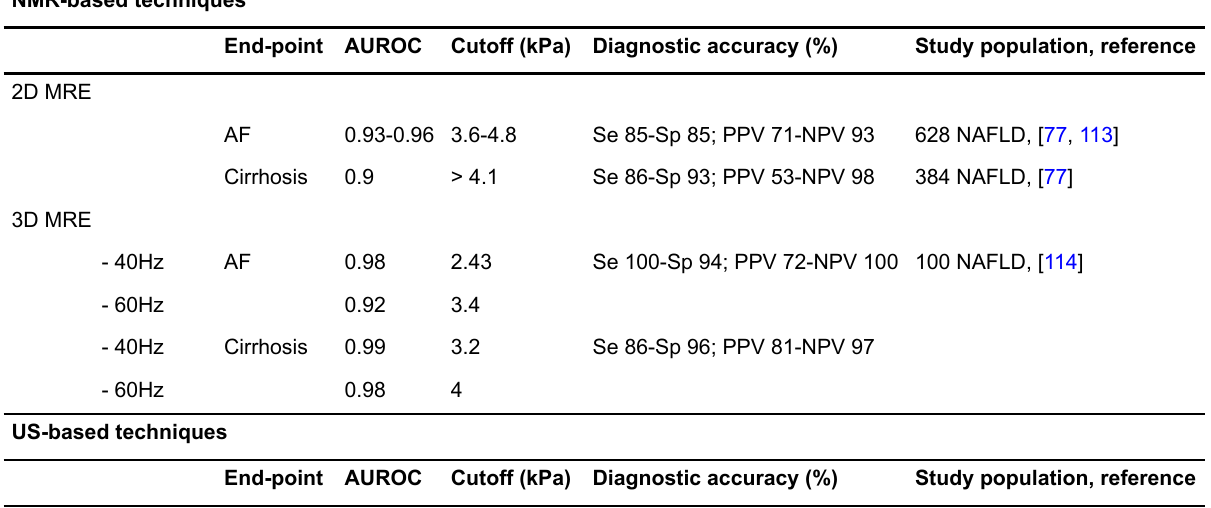
Table 3. Summary of imaging techniques for evaluation of liver stiffness in patients with NAFLD NMR-based